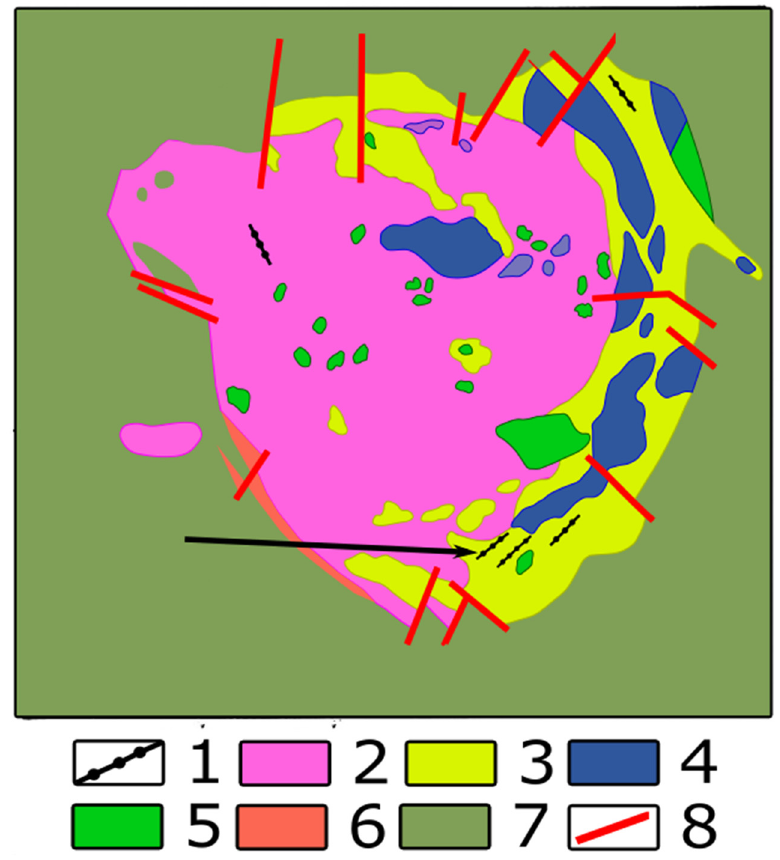
Figure 2. Geological map of Odikhincha massif (simplified from Ref [14]). 1—vines of nepeline- syenite pegmates; 2—ijolites, including melanite ijolites, melaijolites and felspatized melaijolites; 3—melteigites and jacupirangites; 4—melelite rocks; 5—olivinite xenolites; 6—dolerites; 7—Cambrian and Precambrian sedimentary carbonate rocks; 8—faults. The black arrow indicates the sam- pling point.